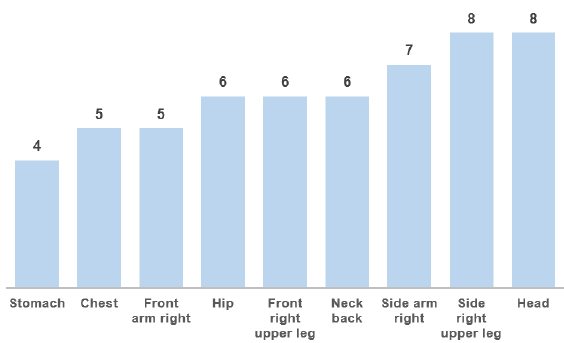
Figure 4. Number of reachable anchors for different on-body tag placement positions.